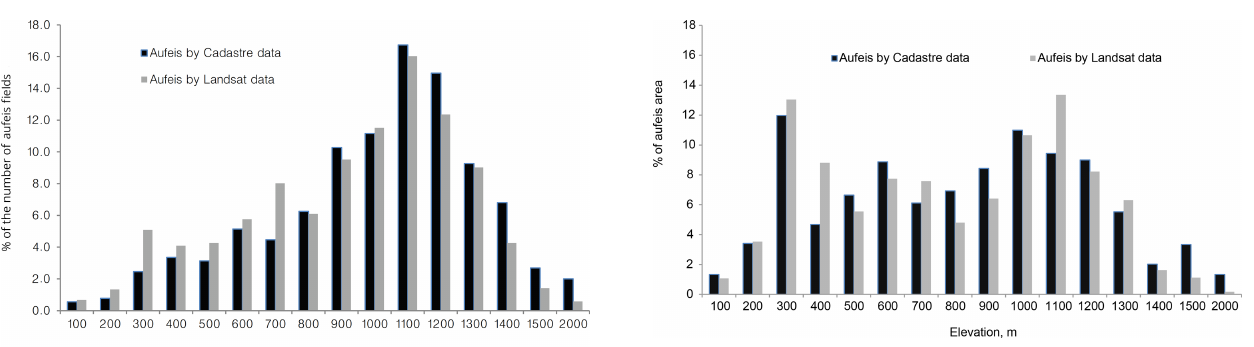
Figure 7. Aufeis area distribution by elevation within the Indigirka River